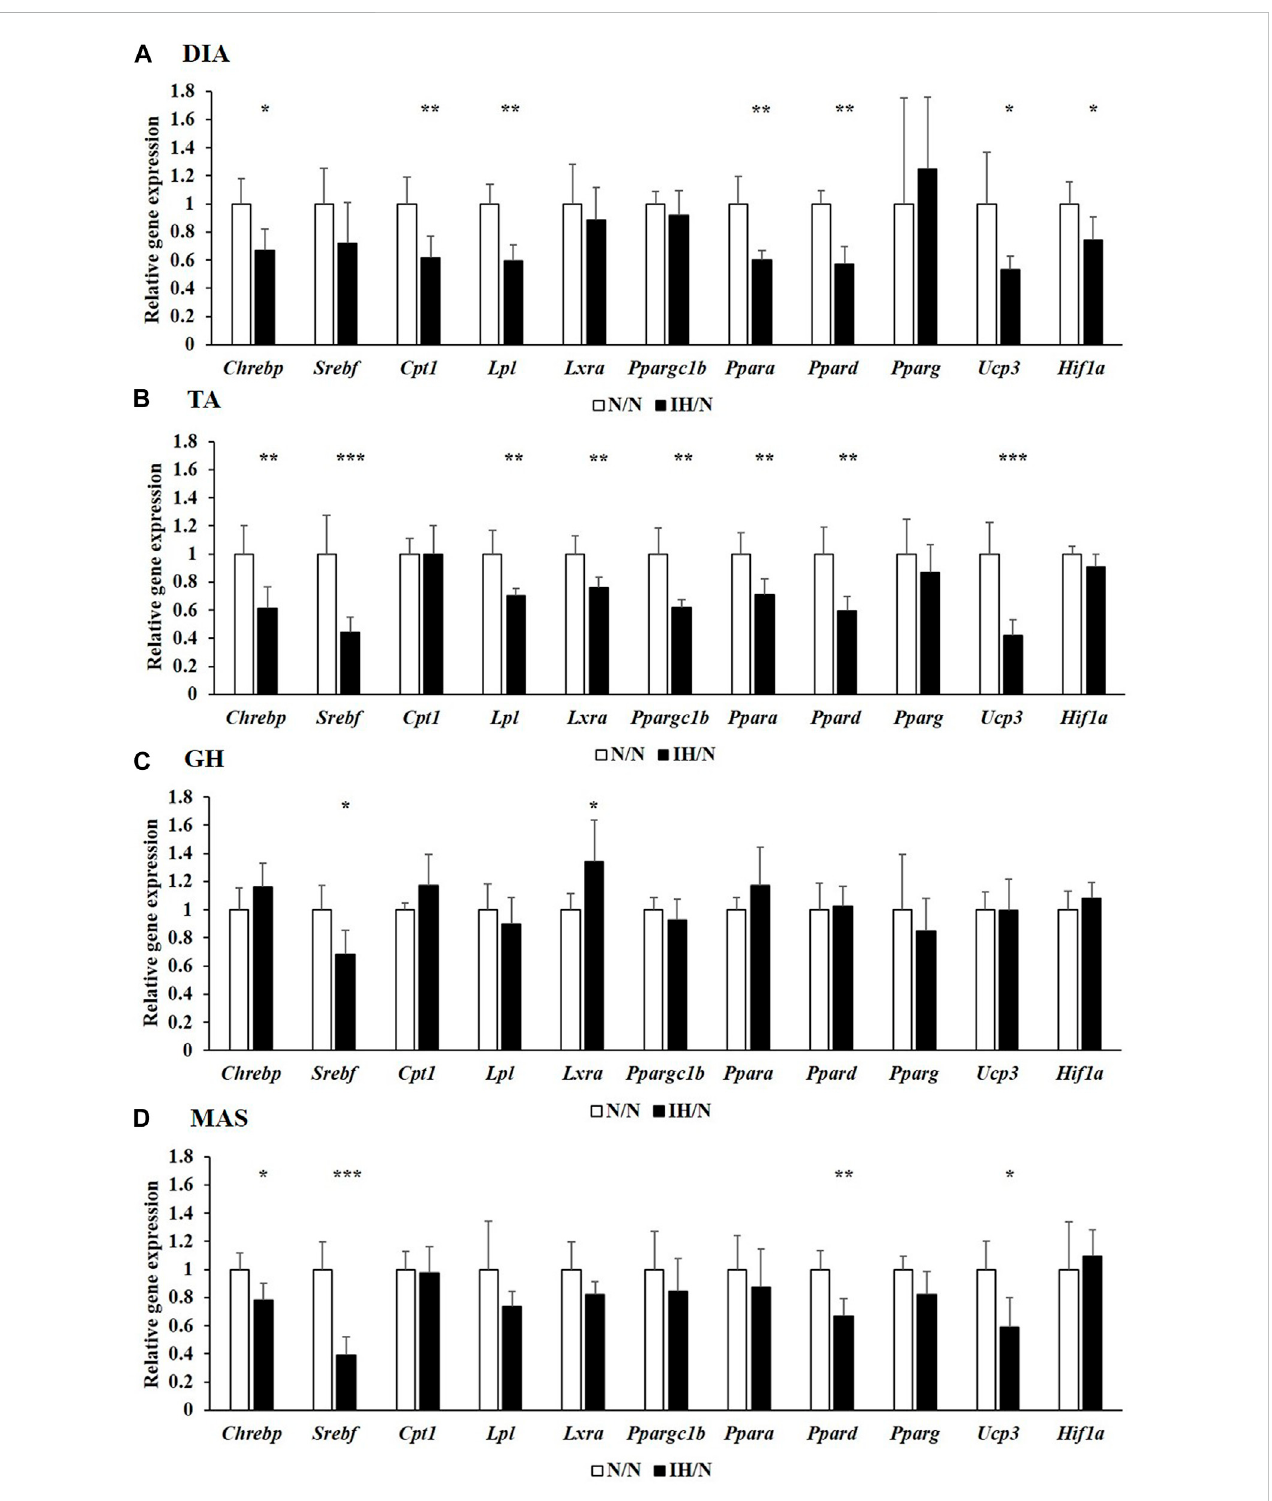
FIGURE 5 Quantitative PCR analysis of genes associated with lipid metabolism. Relative gene expression of Chrebp , Srebf , Cpt1 , Lpl , Lxra , Ppargc1b , Ppara , Ppard , Pparg , Ucp3 ,and Hif1a inthe (A) DIA, (B) TA, (C) GH,and (D) MASmuscleswerenormalizedby Actb andshownasfoldincreaseoftheN/Ngroup* p < .05,** p < .01, *** p <